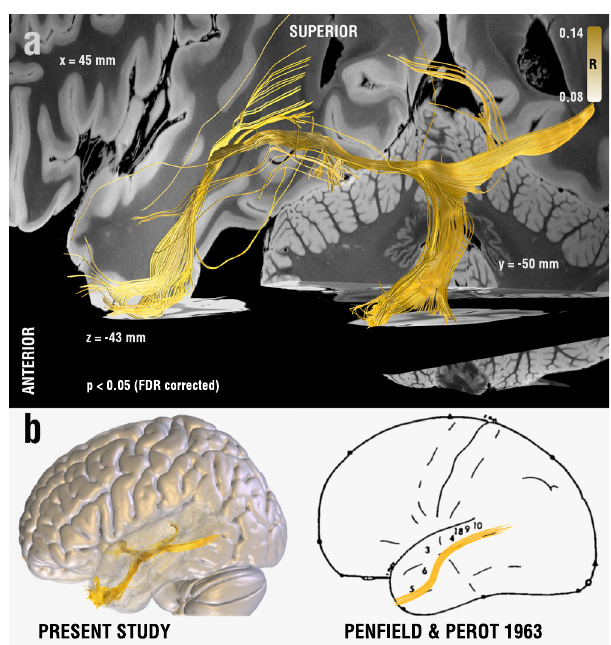
Fig. 6 | White matter bundle associated with occurrence of fl ashback-like phenomena. a Fiber tracts correlated to the presence of fl ashback-like events, connected fi bers were corrected for multiple comparisons using the False Dis- coveryRate(FDR)ata5% α -level. b Brainsurface(lateralview)overlaidwithresults from a (left),incomparisontoPen fi eld ’ soriginalworkonmappingthepresenceof electrical stimulation-induced “ experiential phenomena ” in 40 patients suffering from temporal lobe seizures in a total of 1288 reviewed surgical cases covering a large fraction of the cortical mantle (right). Adapted with permission from 24